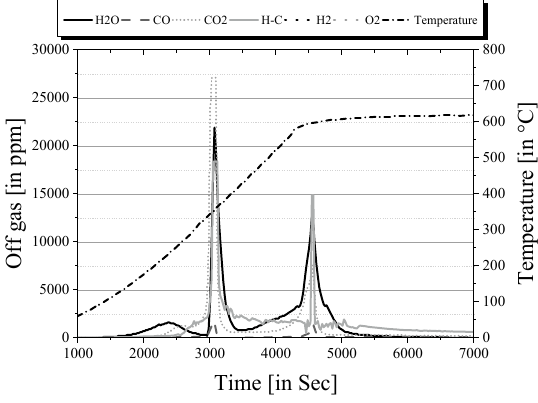
Figure 8. Produced gas analysis in conventional pyrolysis (Reference test).